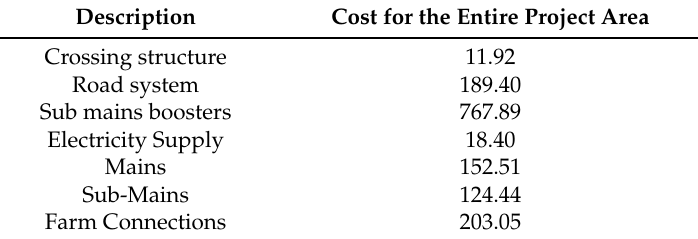
Table 5. Costs in Game c A2,3 .